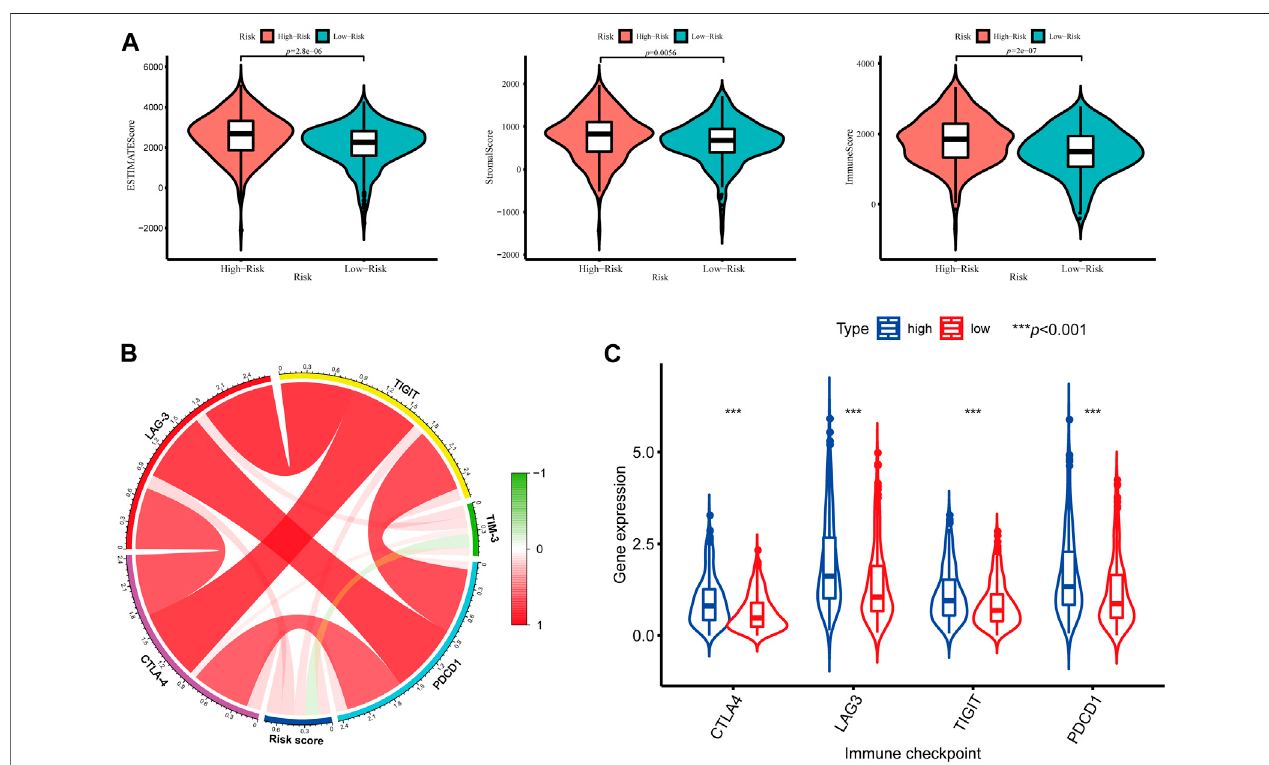
FIGURE 10 | Tumor microenvironment between different risk groups. (A) Estimate scores, stromal scores, and immune scores of different groups; (B) Correlation between the risk score and the expression of immune checkpoints; (C) Signi fi cant differentially expressed immune checkpoints between high- and low-risk patients.